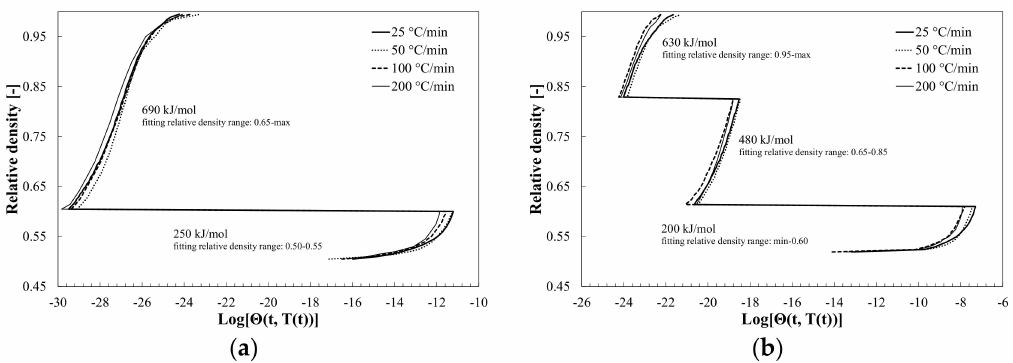
Figure 7. ( a ) Master sintering curve with corresponding apparent activation energy for spark plasma sintering of Y-doped alumina. Stress exponent measurements did not reveal any mechanism change, and after particle rearrangement at sintering onset, the sintering curves collapse into a single domain master curve with an apparent activation energy equivalent to the one measured in natural sintering (670 kJ / mol). ( b ) Master sintering curve with corresponding apparent activation energy for spark plasma sintering of La-doped alumina. Due to extensive viscous flow in the intermediate sintering stage, confirmed by a stress exponent analysis and change, the predominant mechanisms change during the sintering cycle such that the sintering curves do not collapse into a single domain MSC. At the final sintering stage an apparent activation energy of 630 kJ / mol is reasonably equivalent to the one measured in natural sintering varying between 700–780 kJ / mol [54]. (reprinted with permission of Materials Research